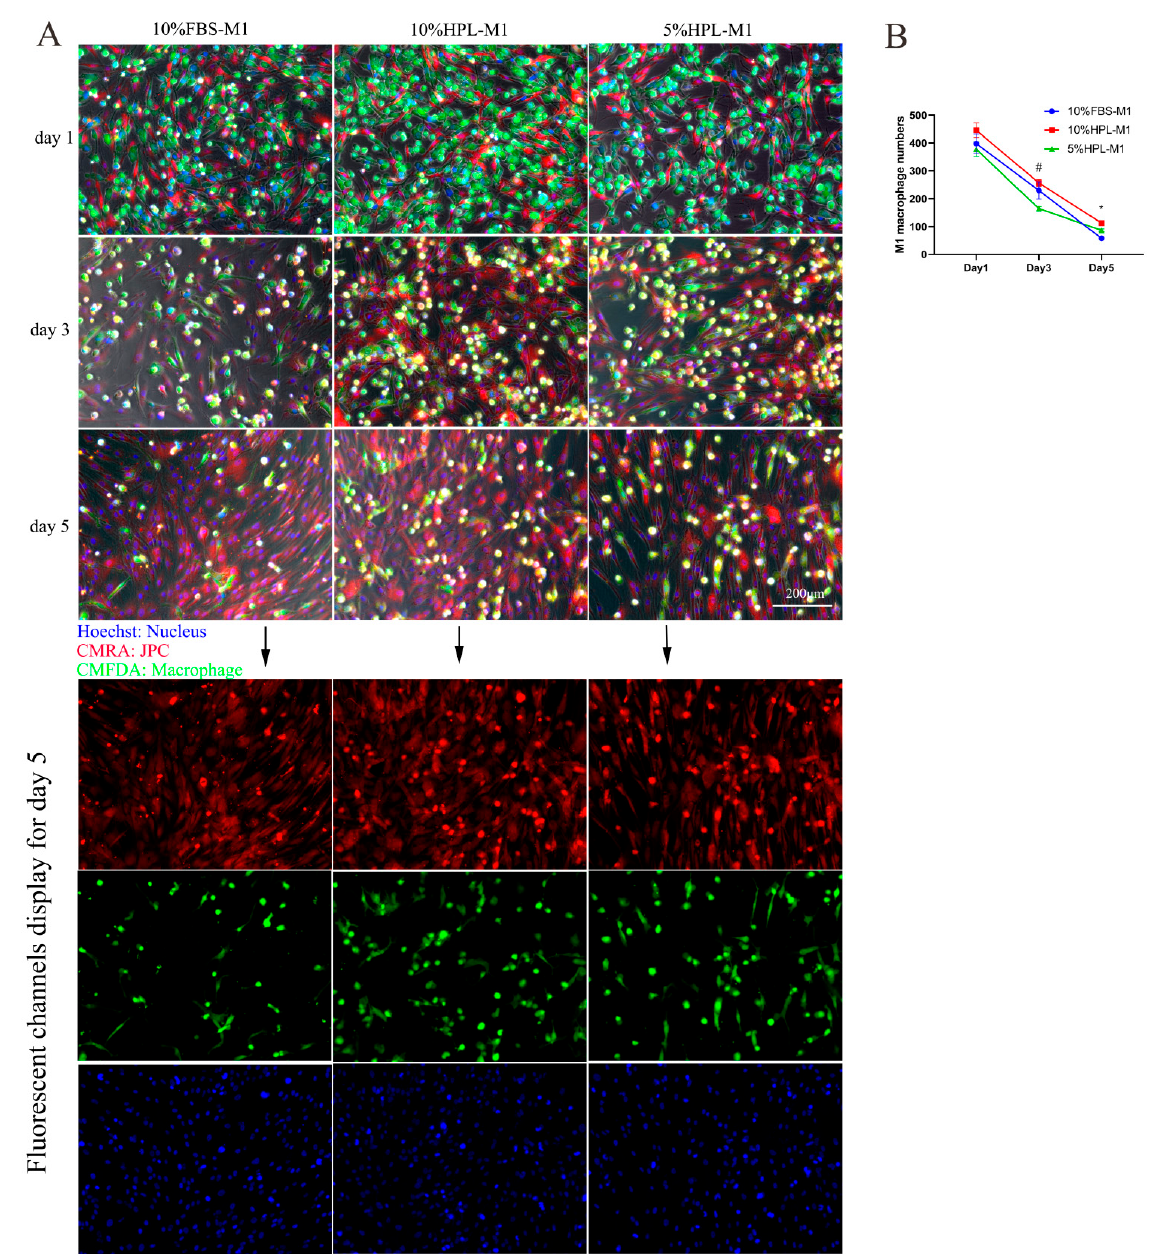
Figure 7. Cell tracking of JPC and M1 macrophages cultured under 10% FBS, 10% hPL, or 5% hPL culture supplementation by fluorescence microscopic imaging. ( A ) Representative fluorescence micrographs of JPCs and M1 macrophages on the first, third, and fifth days of coculture (blue: nucleus; red: JPC; green: macrophage); scale bar: 200 µ m. ( B ) M1 macrophage numbers counted in the fluorescence images at days 1, 3, and 5 of coculture with JPCs ( n = 3, 5% hPL compared with 10% FBS * p < 0.05, 5% hPL compared with 10% hPL # p <